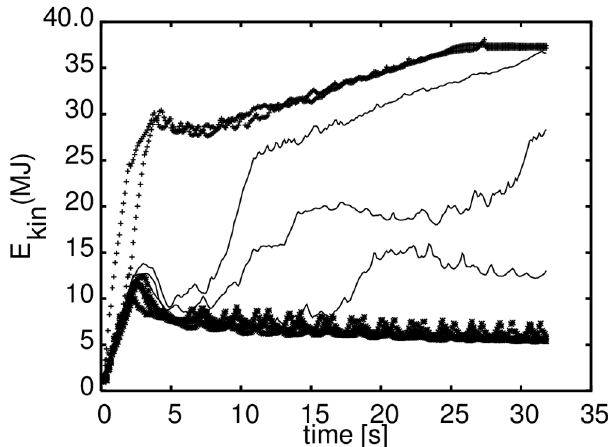
Fig. 9. Model test result for Glen’s flow law. Five constant shear stresses were applied to a test block and strain rate was measured and viscosity extracted. The melting-refreezing probabilities are set so that the pre-factor, A , in Glen’s flow law is of the order 10 − 10 , rather than 10 − 24 , which would be the realistic range for ice: the simulated material in its shear dependent behaviour resem- bles Glen’s flow law but has an overall viscosity that is about 14 orders of magnitude lower than that of ice. This corresponds to a viscosity roughly at the same order of magnitude as that of bitumen or asphalt. The simulation data is represented by red markers and fitting the function, x B /A gave A ≈ 1 . 5 × 10 − 10 , B ≈ − 2 . 0 as it